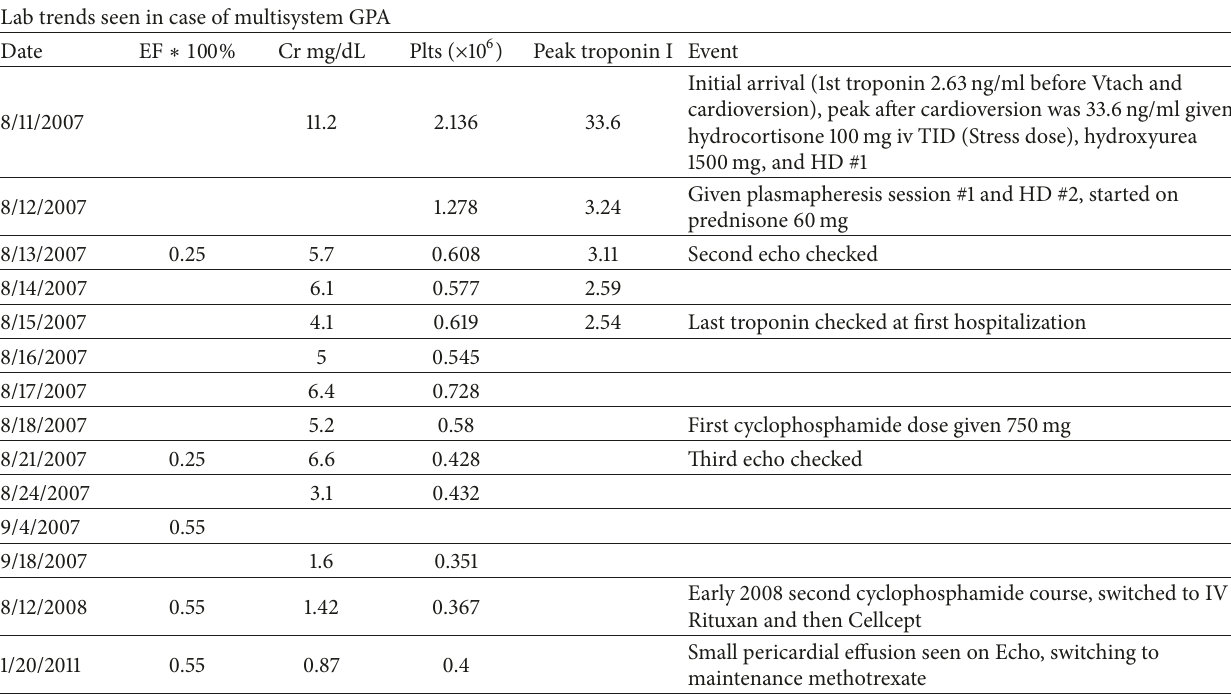
Table 1: Table of trends and clinical timeline of events, following trends from 2007 to 2011. Lab trends seen in case of multisystem